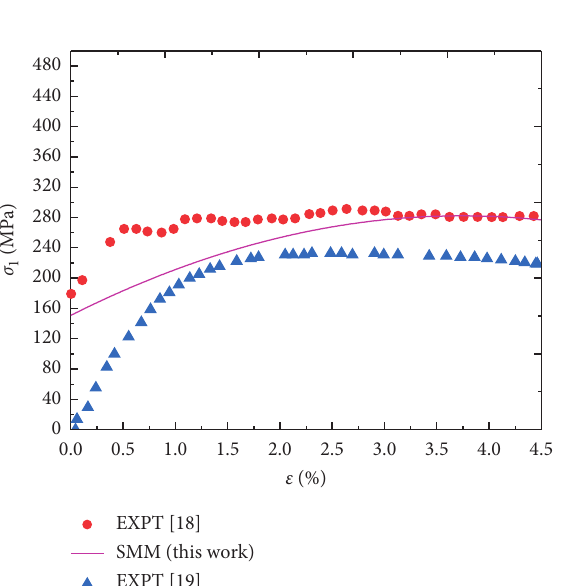
Figure 2: The real stress σ ( ε ) of Au at T � 300K and P � 0 calculated by the SMM and from EXPT [11] and EXPT [12]. 1